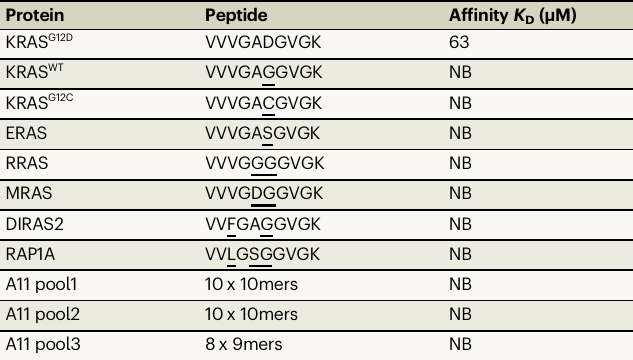
Table 1 | Soluble JDI TCR binding tested against HLA-A*11:01 presented KRAS G12D peptide, mimetic peptides and random peptide pool using surface plasmon resonance Protein